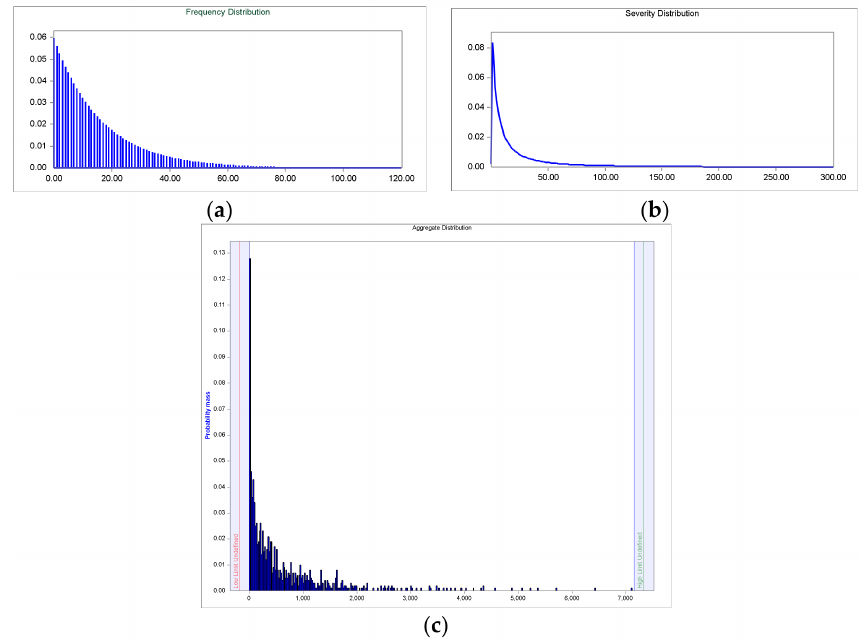
Figure 7. Non Clinical-VaR: ( a ) Frequency histogram of the geometric distribution; ( b ) Probability density function (PDF) of the Log-Normal distribution; ( c ) Loss distribution approach